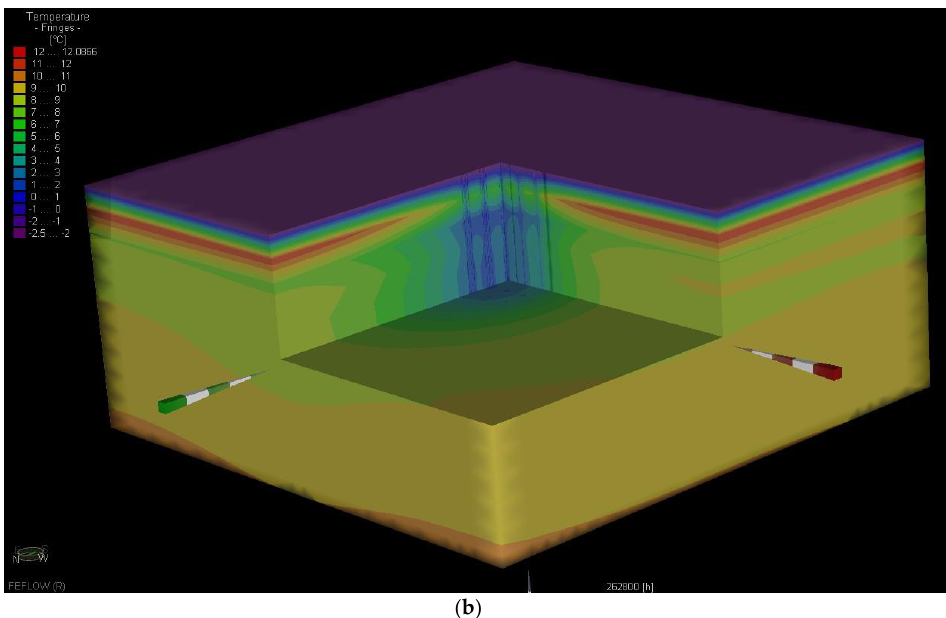
Figure 14. Results of 3D simulation of ground temperature after 10 years ( a ) and 30 years ( b ) of heat